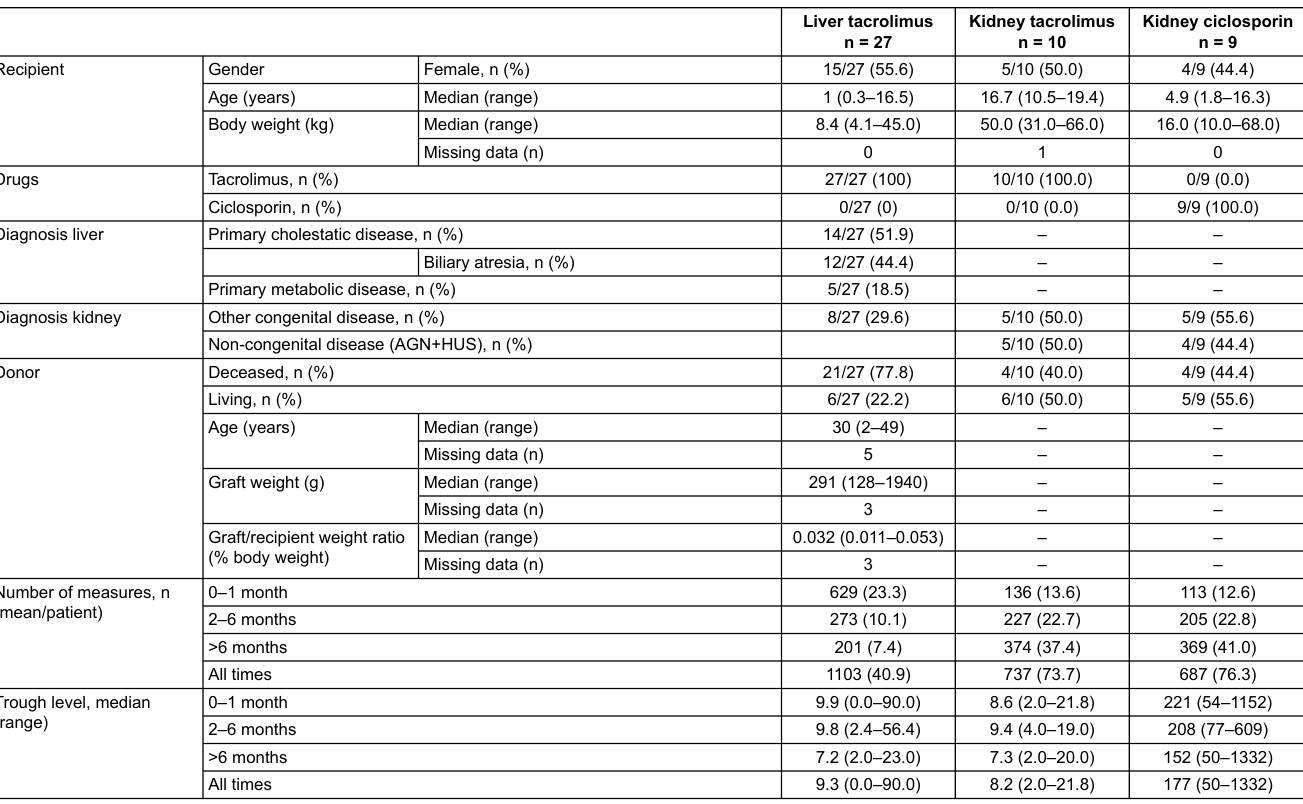
Table 1: Paediatric liver and kidney transplant patients: recipient and donor